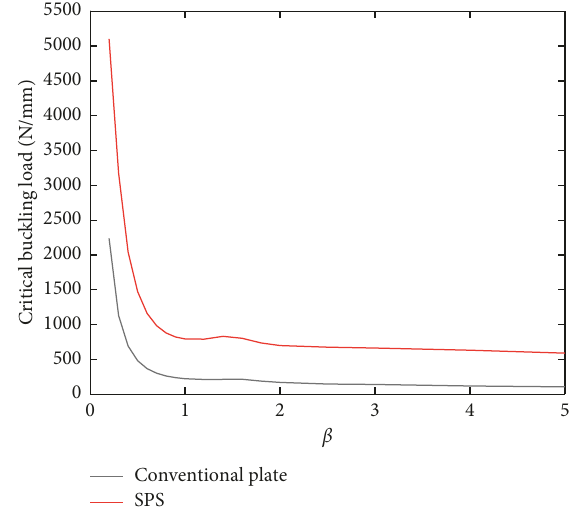
Figure 13: Critical buckling loads in ribbed SPS and conventional plates with different length-to-width